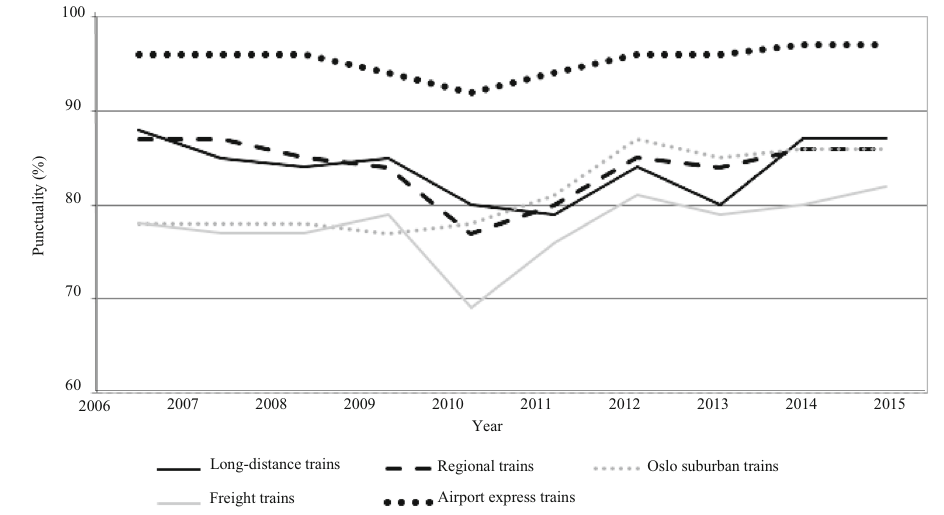
Fig. 2 Punctuality trend of different train services. Data source: Jernbaneverket